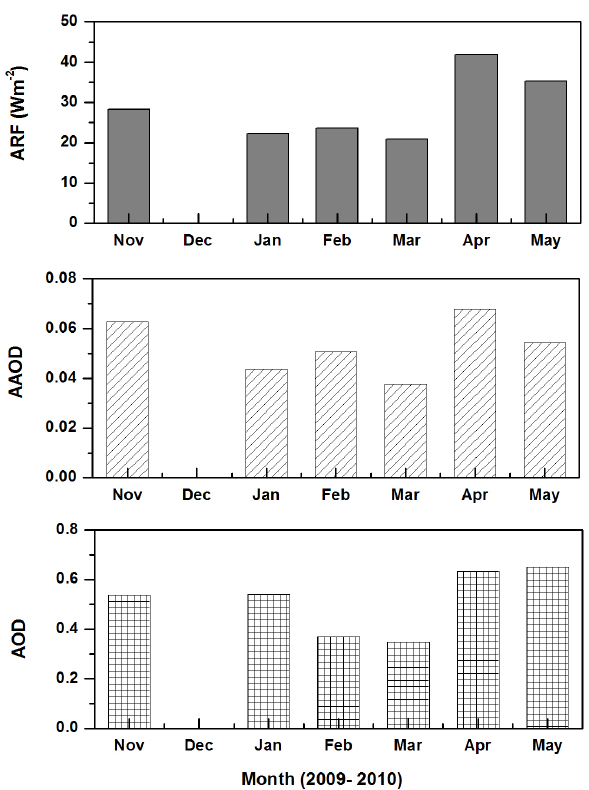
Fig. 16. Monthly mean aerosol optical depth (AOD), absorption aerosol optical depth (AAOD) and aerosol atmospheric radiative forcing (ARF) in the broadband region over